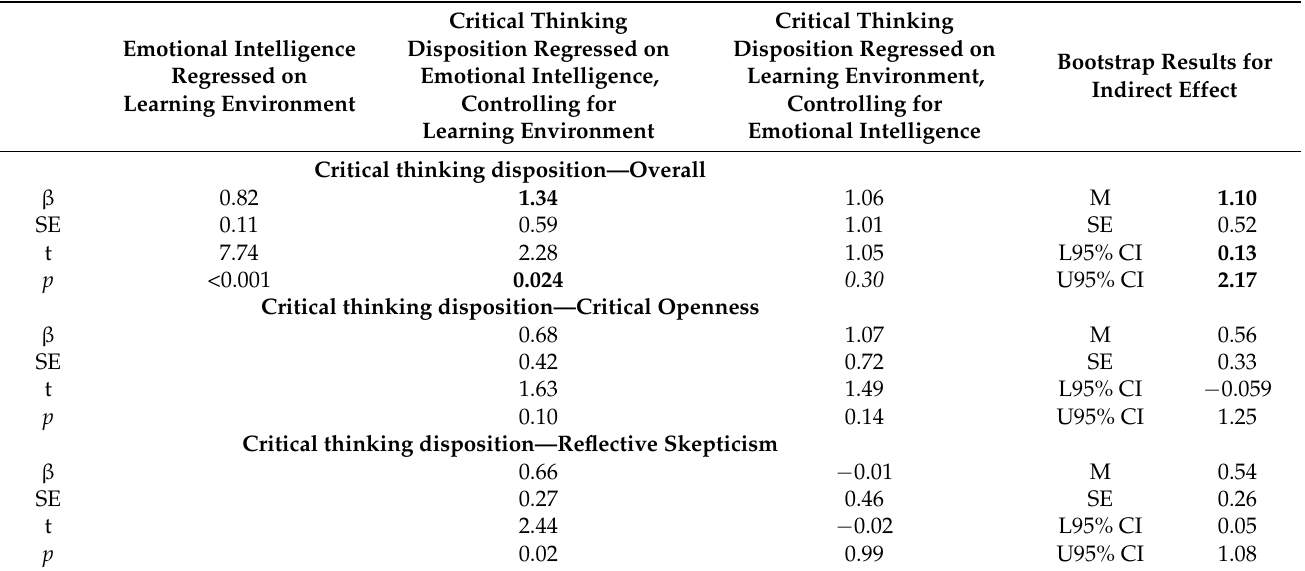
Table 3. Regression analyses between Critical Thinking Disposition Scale (CTDS), Dundee Ready Education Environment Measure (DREEM), and Trait Emotional Intelligence Questionnaire Short Form